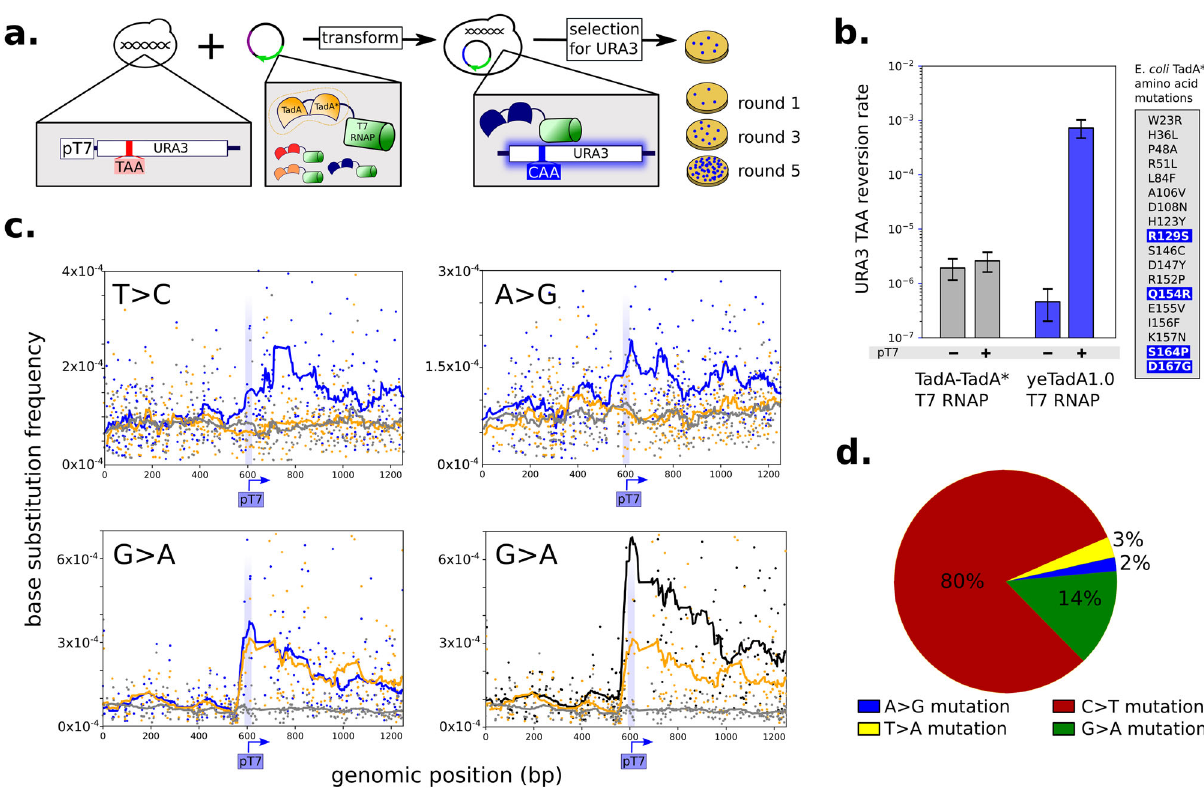
Fig. 3 An engineered adenosine deaminase increases targeted A/T mutation rate. a Schematic of strategy to evolve an adenosine deaminase for targeted mutagenesis when fused to T7 RNAP. Screening strain containing URA3 with a premature TAA stop codon is transformed with libraries of TadA- TadA* adenosine deaminase fused to T7 RNAP (left). TadA-TadA* variants with enhanced A/T mutagenesis correct the TAA stop codon in URA3 more frequently and grow on uracil-lacking media. DNA is extracted from colonies grown on uracil-lacking media, and used in subsequent round of TadA-TadA* library generation and enrichment. Iterating the process yields increased numbers of colonies on uracil-lacking plates (rounds 1 – 5) as TadA-TadA* variants with enhanced A/T mutagenesis enrich. b A/T targeted mutation rate in strain CSY1256 measured by reversion of a TAA stop codon in URA3 and quanti fi ed using the Falcor algorithm. The on/off-target mutation rates are compared for parent enzyme BE7.10 (gray, pCS4332) and newly engineered variant yeTadA1.0 (blue, pCS4333). Consensus mutations resulting from 5 rounds of evolution (in blue) with pre-existing TadA* mutations (gray). Error bars represent 95% con fi dence intervals measured from eight independent cultures induced with 0.2% galactose. c Mutation frequencies for different substitution types (left corner of each plot), plotted by position along URA3 for strains with the engineered yeTad1.0 incorporated (YHM5, blue lines; YHM6, black lines) and control lacking yeTadA1.0 (YHM2, yellow lines) and control lacking T7 targeting (YHM2.P T7 KO, gray lines) when induced with 100 nM β -estradiol for 16 h. In order to match YHM2 and YHM2.P T7 KO, data from YHM2.P T7 KO is off-set by 23 bp, accounting for the T7 promoter. Mutation data generated by next-generation sequencing (NGS) at URA3 as described in “ Methods ” . d Fraction of base substitutions occurring at each base in the mutator strain YHM6 as measured by NGS; substitutions occur across all four nucleotides. Mutation frequencies were calculated in duplicate from NGS data across bases 1000 – 1200 at URA3 in YHM6 and for each substitution type the background sequencing error frequencies (calculated from